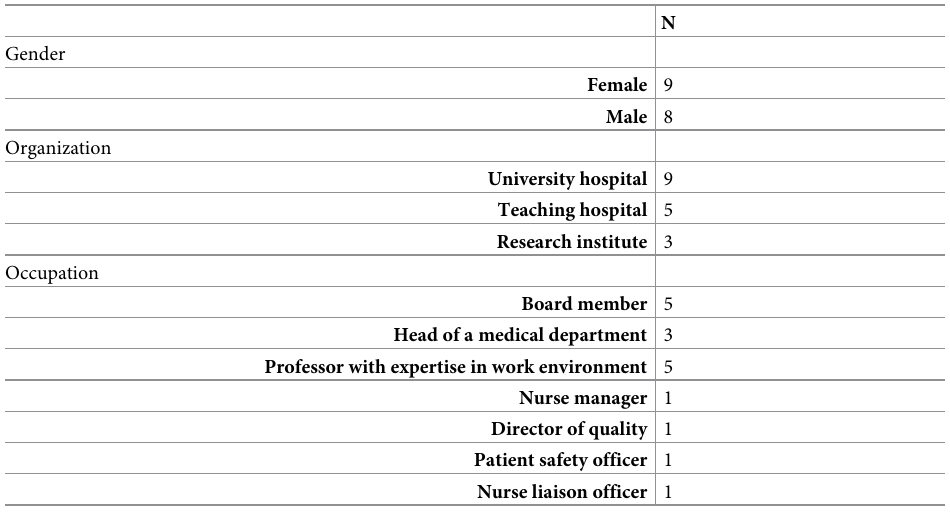
Table 1. Demographics of interview